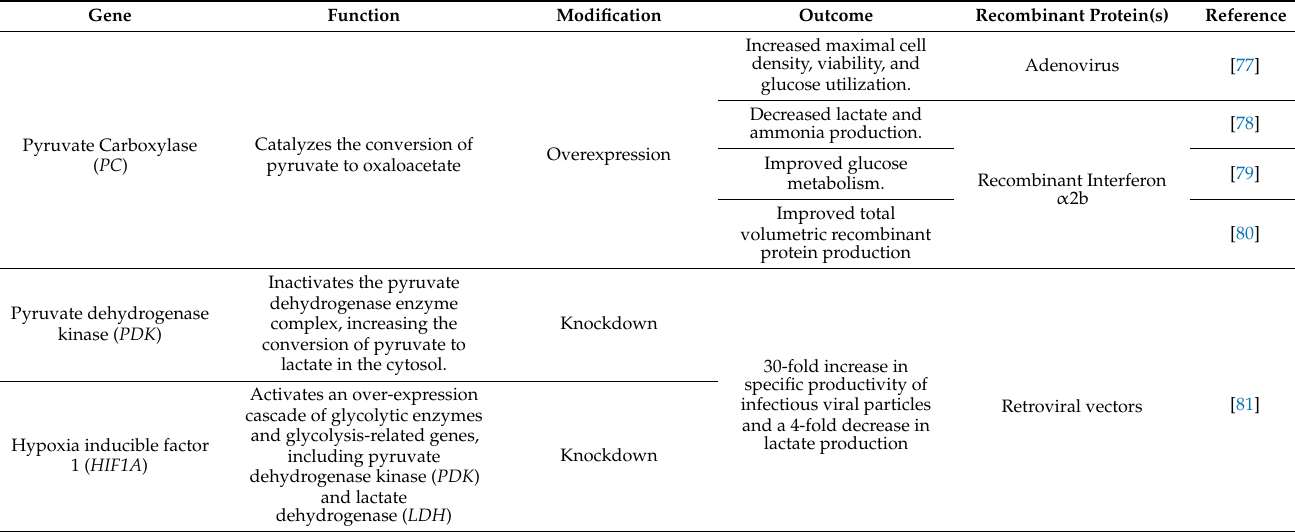
Table 4. Genes that have been engineered to improve central carbon metabolism in the HEK293 cell